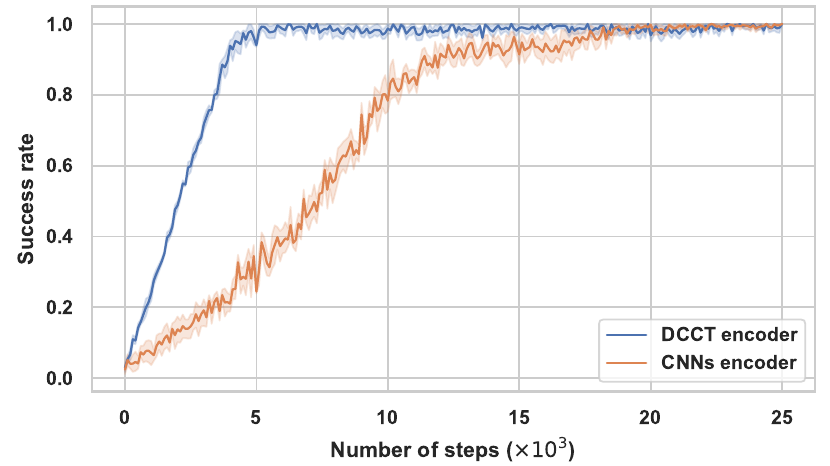
Figure 5. Performance of Transformer encoder ablation. Training performances (success rate) of with-Transformer encoder and without-Transformer encoder in Reach task. Mean and std. deviation of 25